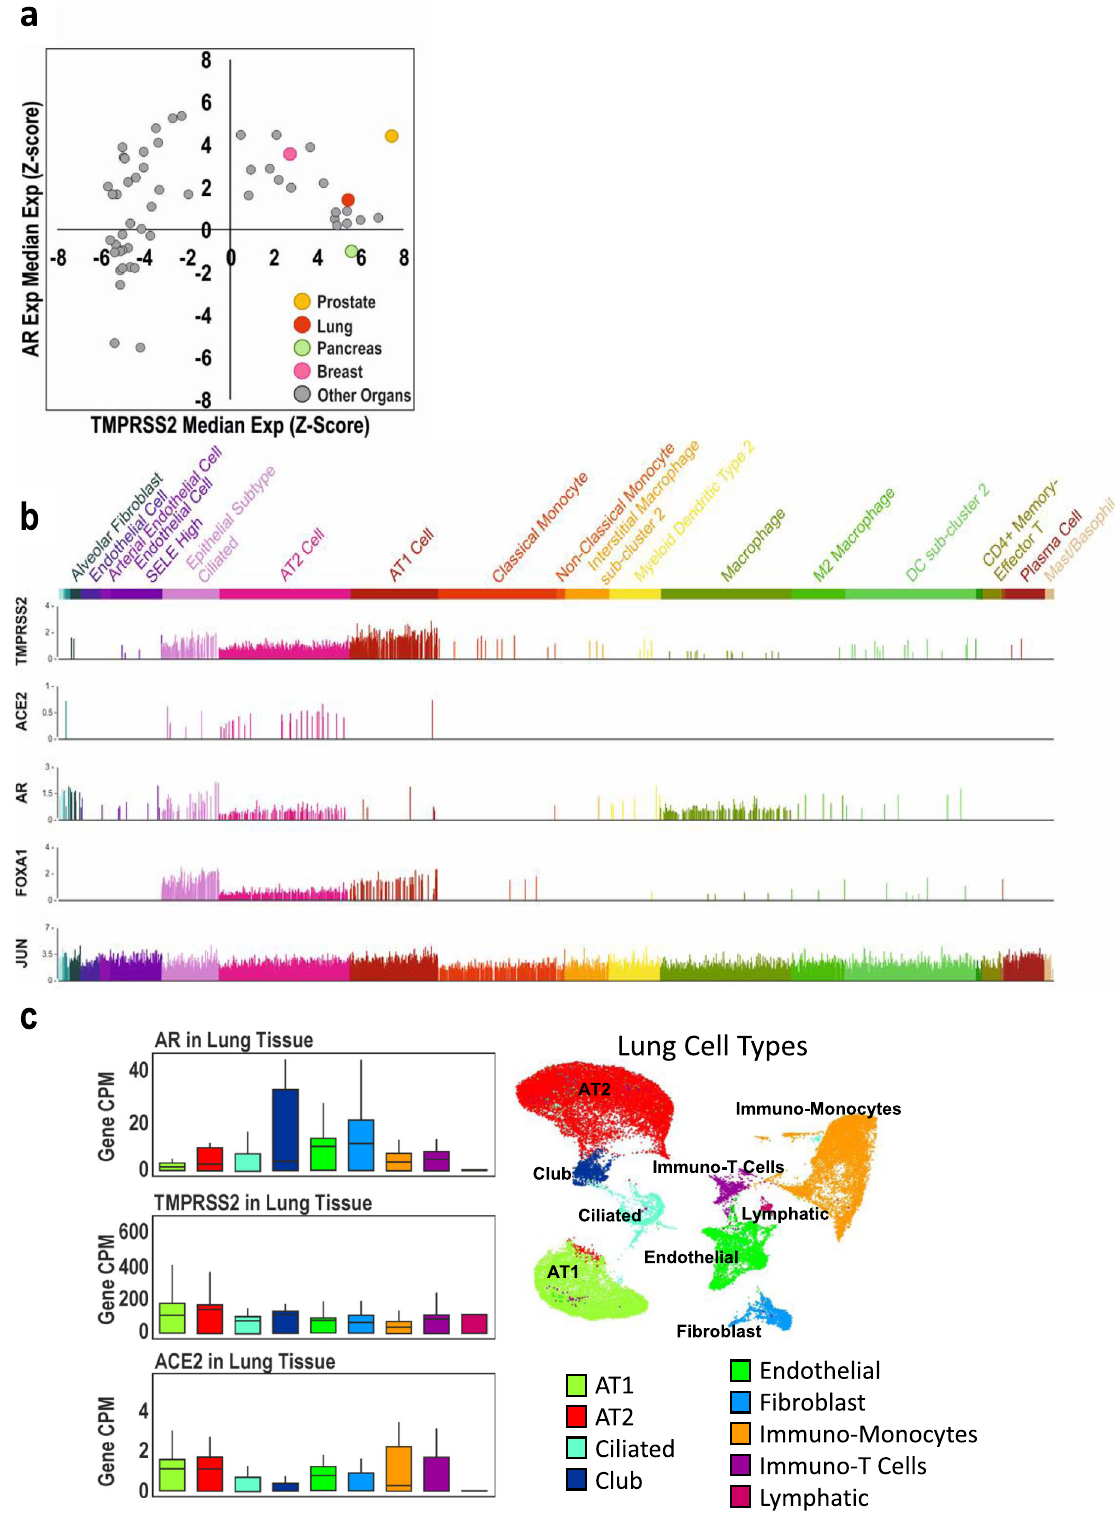
Fig. 2 TMPRSS2 and the AR are expressed in the lung. a The GTEx dataset 40 was interrogated and median expression of AR was plotted against median TMPRSS2 expression. Data are expressed as each gene normalised across all tissues ( z -score). Highlighted are prostate ( n = 245), lung ( n = 578), pancreas ( n = 328) and breast ( n = 459). b Single-cell analysis of lung tissue 41 with each bar representing AR, TMPRSS2, ACE2, FOXA1, JUN expression within individual cells of each speci fi ed cell type. c Single-cell analysis of lung tissue 42 was interrogated and a breakdown is shown of AR, TMPRSS2 and ACE2 expression levels in speci fi c lung cell types (X-axis); Y-axis denotes gene mRNA